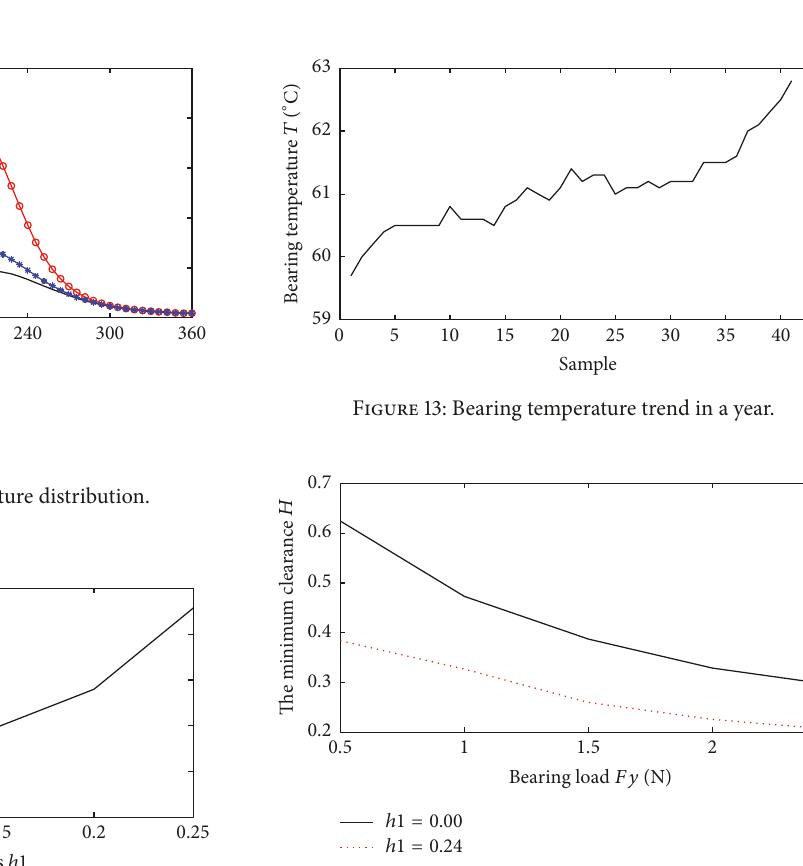
Figure 10: Comparison of journal eccentricity ratio and attitude angle.